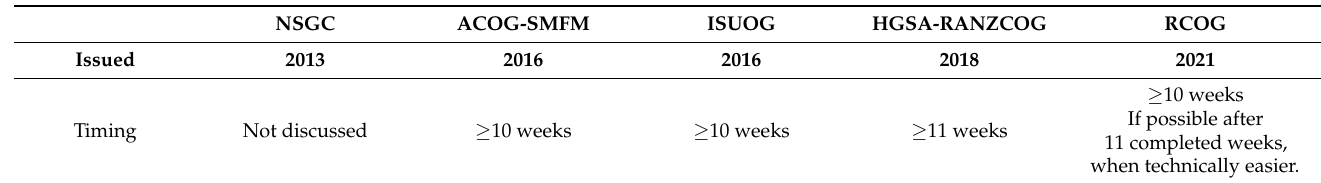
Table 3. Summary of recommendations on chorionic villus